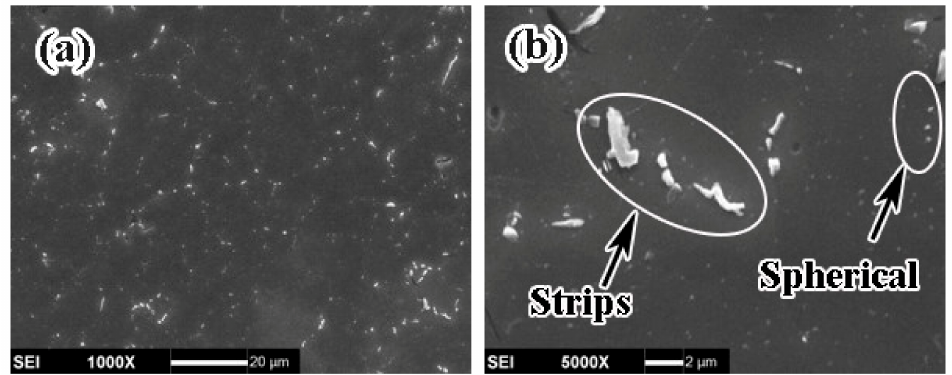
Figure 7. SEM images of the white precipitate phase in the GO/TiAl composites. ( a )1000 multiple. ( b ) 5000 multiple of sample.